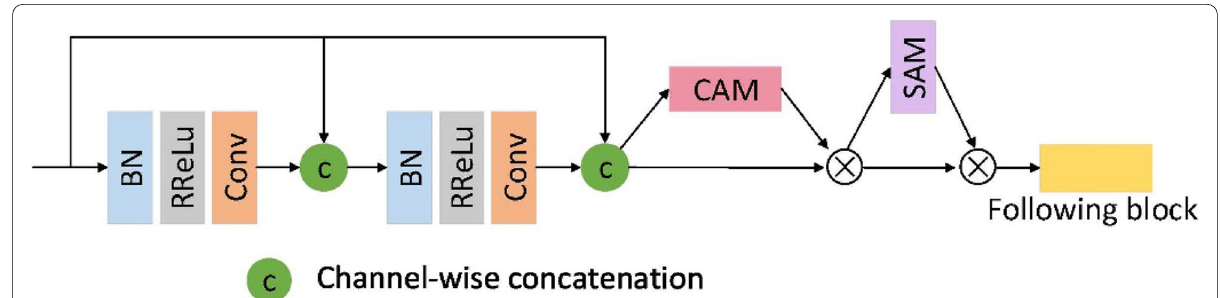
Fig. 3 Integration of the CBAM with the dense